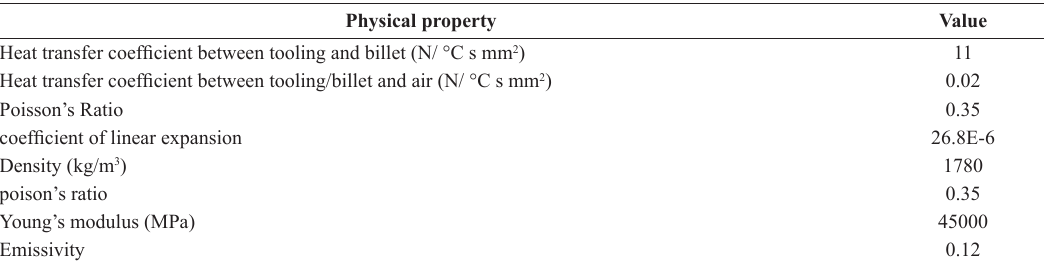
Table 1. Physical properties of the AZ31 workpiece.